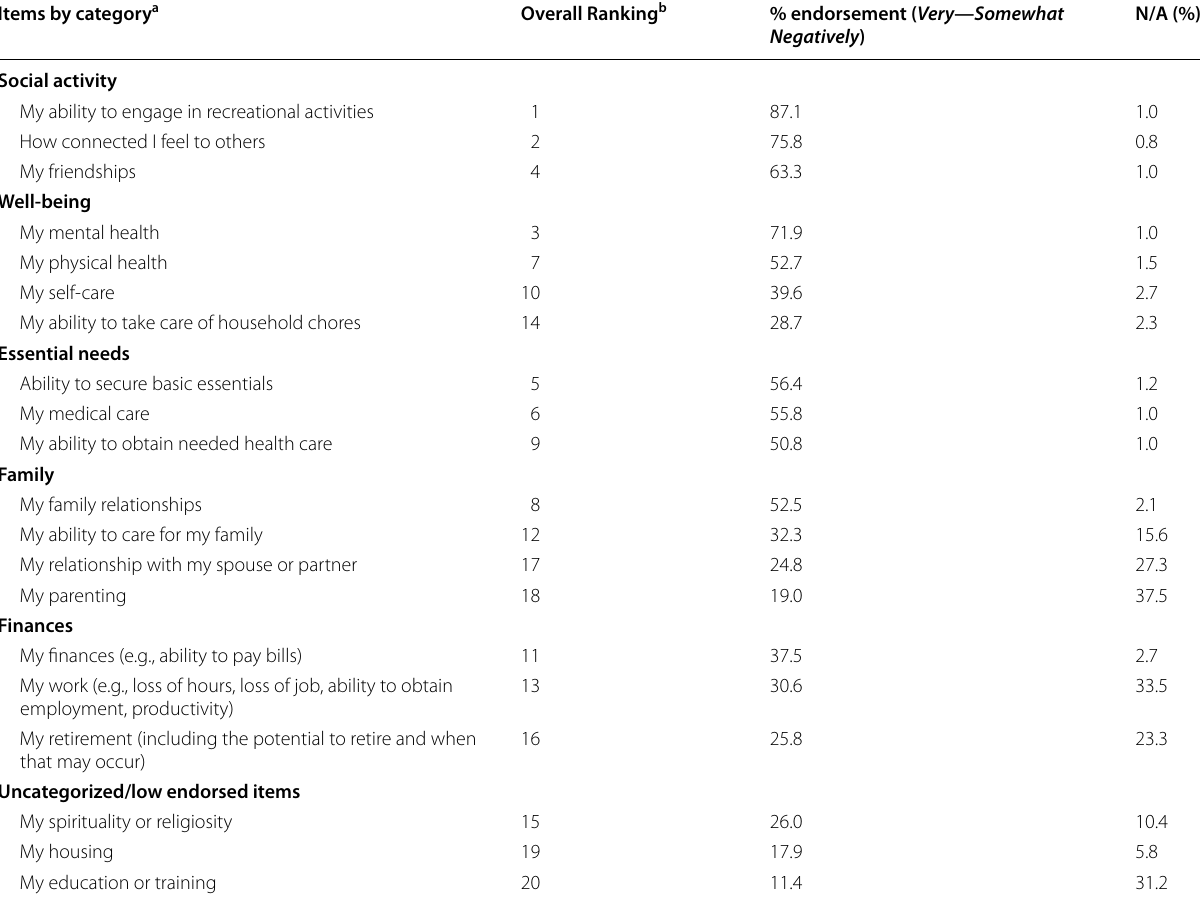
Table 2 COVID-19 impact item endorsement and ranking by